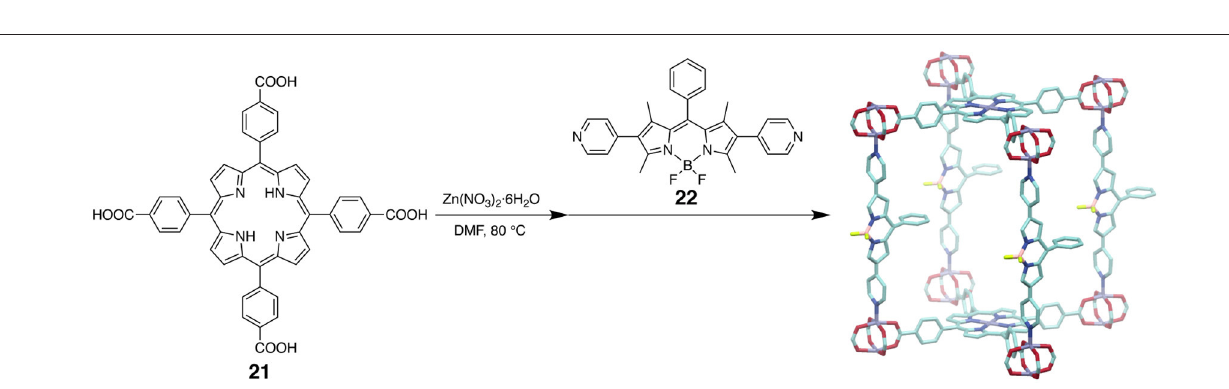
center was either the Ag(I) or Zn(II) ion. In particular, the MOF composed of a cyanophenyl-appended dipyrrin ligand was robust to solvent removal, and adsorbed various aromatic guest molecules. In addition, the MOF more strongly adsorbed nitroaromatic compounds than